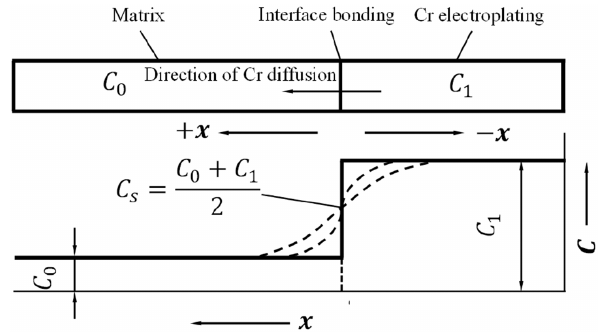
Figure 2: Schematic diagram of component – distance relation in the diffusion couple model [22].